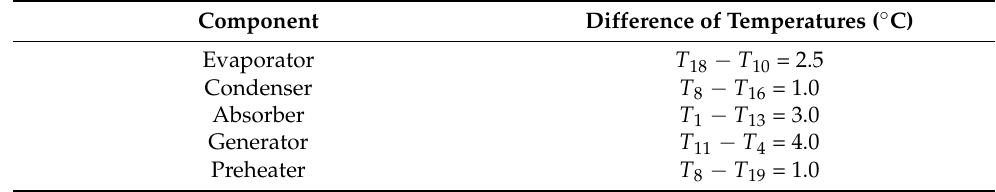
Table 2. Minimum approach temperature difference for each cycle